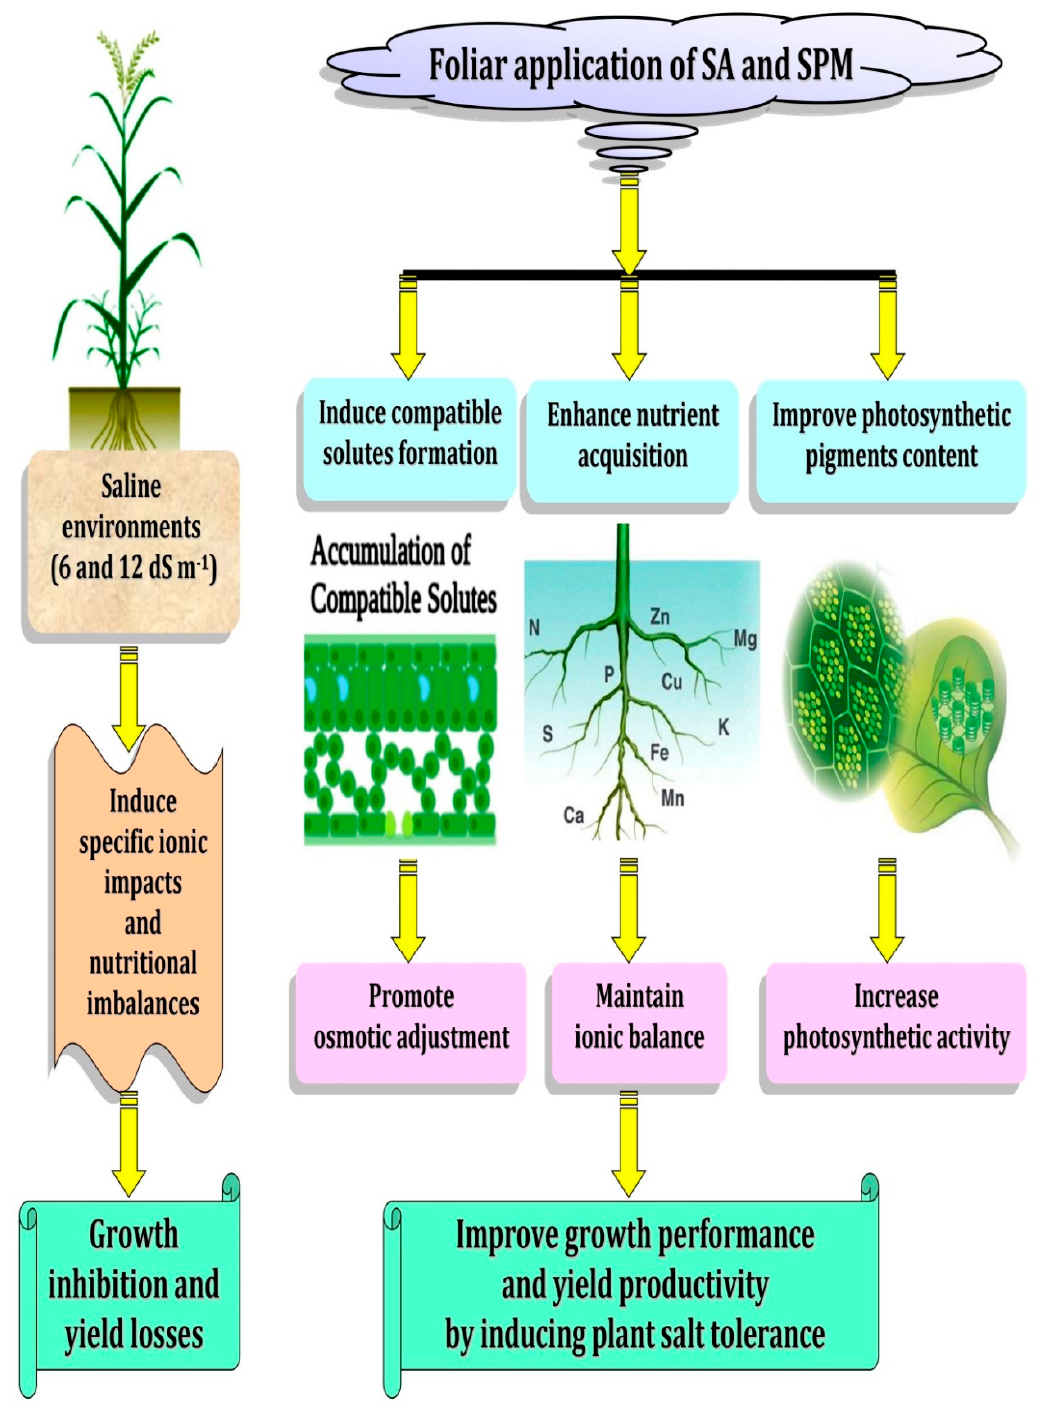
Figure 11. A model showing saline environments inhibit growth and productivity of wheat plants by inducing specific ionic effects and nutritional imbalances. Meanwhile, salicylic acid (SA) and spermine (SPM) reduce salt stress damage to the plant by improving photosynthetic pigment content, enhancing nutrient acquisition, and inducing osmolytes accumulation, thereby helping plants maintain ionic and osmotic balances.